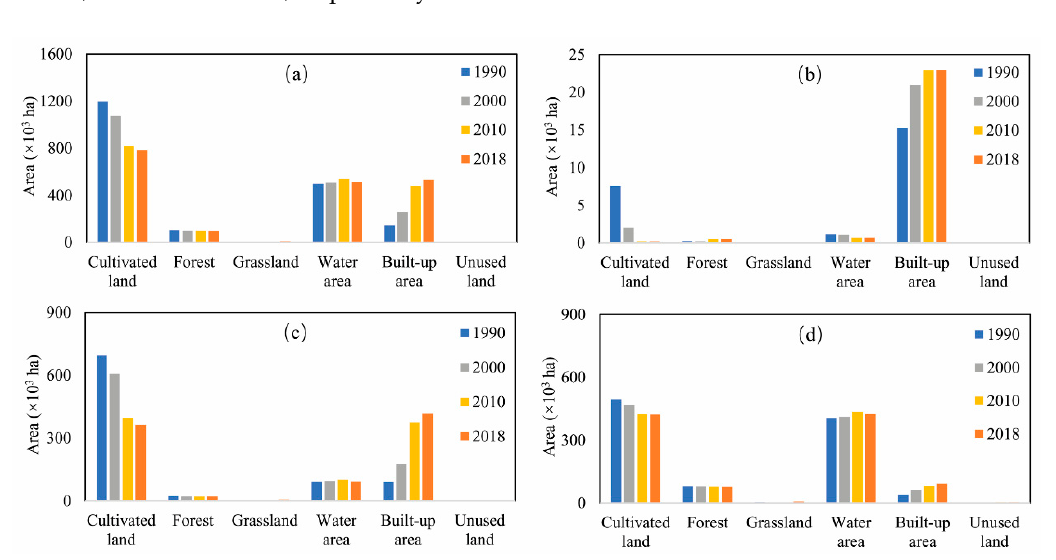
Figure 3. Quantitative changes in different land-use types from 1990–2018. ( a ) The whole study area, ( b ) Developed urban area, ( c ) Developing urban area, ( d ) Rural area.